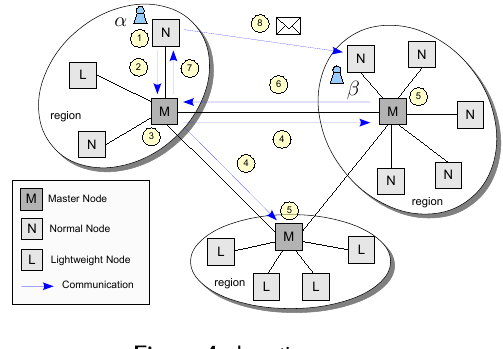
Figure 4. Location